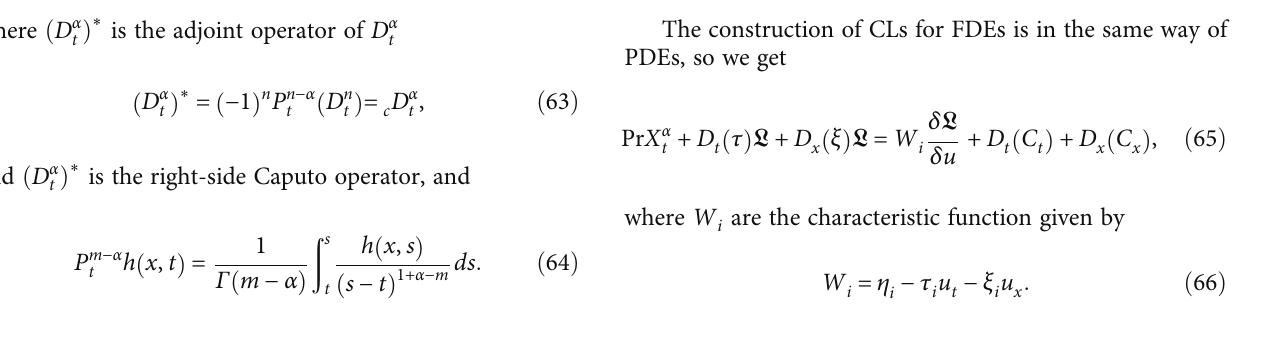
= 2, a = 5, a = 1 . 0 1 2